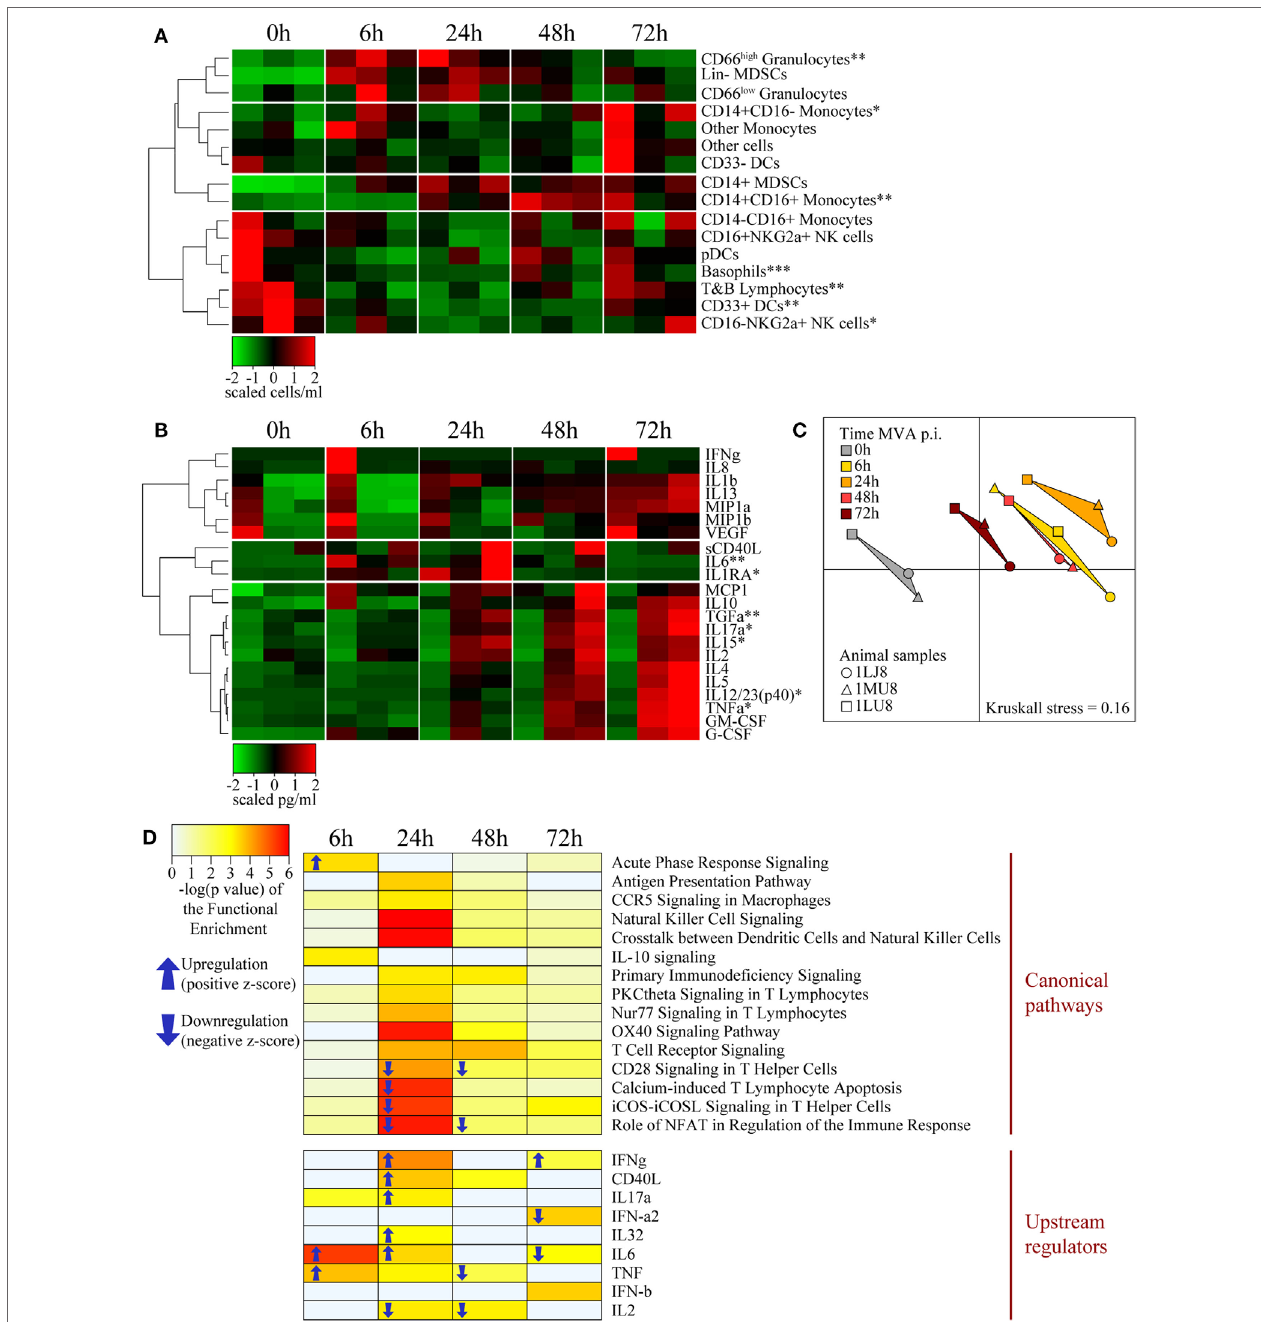
FigUre 5 | Systemic effects of intradermal rMVA injection. (a) Heatmap representation of blood cell populations discriminated by flow cytometry. Cell populations were automatically sorted following hierarchical clustering represented by the dendrogram on the left. The number of cells/milliliter was calculated using the number of leukocytes obtained by complete blood count analysis. Values were standardized to display the same range of expression values for each cell population to properly visualize the cell population kinetics. See Figures S3C,D in Supplementary Material for gating strategies. (B) Heatmap representation of cytokine release in the blood after rMVA injection. Plasma cytokine titrations were automatically sorted following hierarchical clustering represented by the dendrograms on the left. Values were standardized to display the same range of expression for each cytokine to properly visualize the cytokine production kinetics. (c) Multidimensional scaling representation of transcriptomic signatures in the blood after rMVA injection. Biological samples are represented as dots in a two-dimensional space. The distances between the dots are proportional to the Euclidian distances between the transcriptomic profiles. (D) Heatmap representation of functional enrichment. Data were extracted from differentially expressed genes relative to the baseline condition and functional enrichment expressed as − log( p -value), with a cutoff − log( p -value) > 3 for at least one time-point. Only differentially expressed canonical pathways and upstream regulators linked to the immune response are represented. Arrows correspond to the sign of the z -score, indicating the orientation of the expression of the group of genes ( n = 3). *0.05 > p -value > 0.01; **0.01 > p -value > 0.001; ***0.001 > p -value in Friedman’s test over